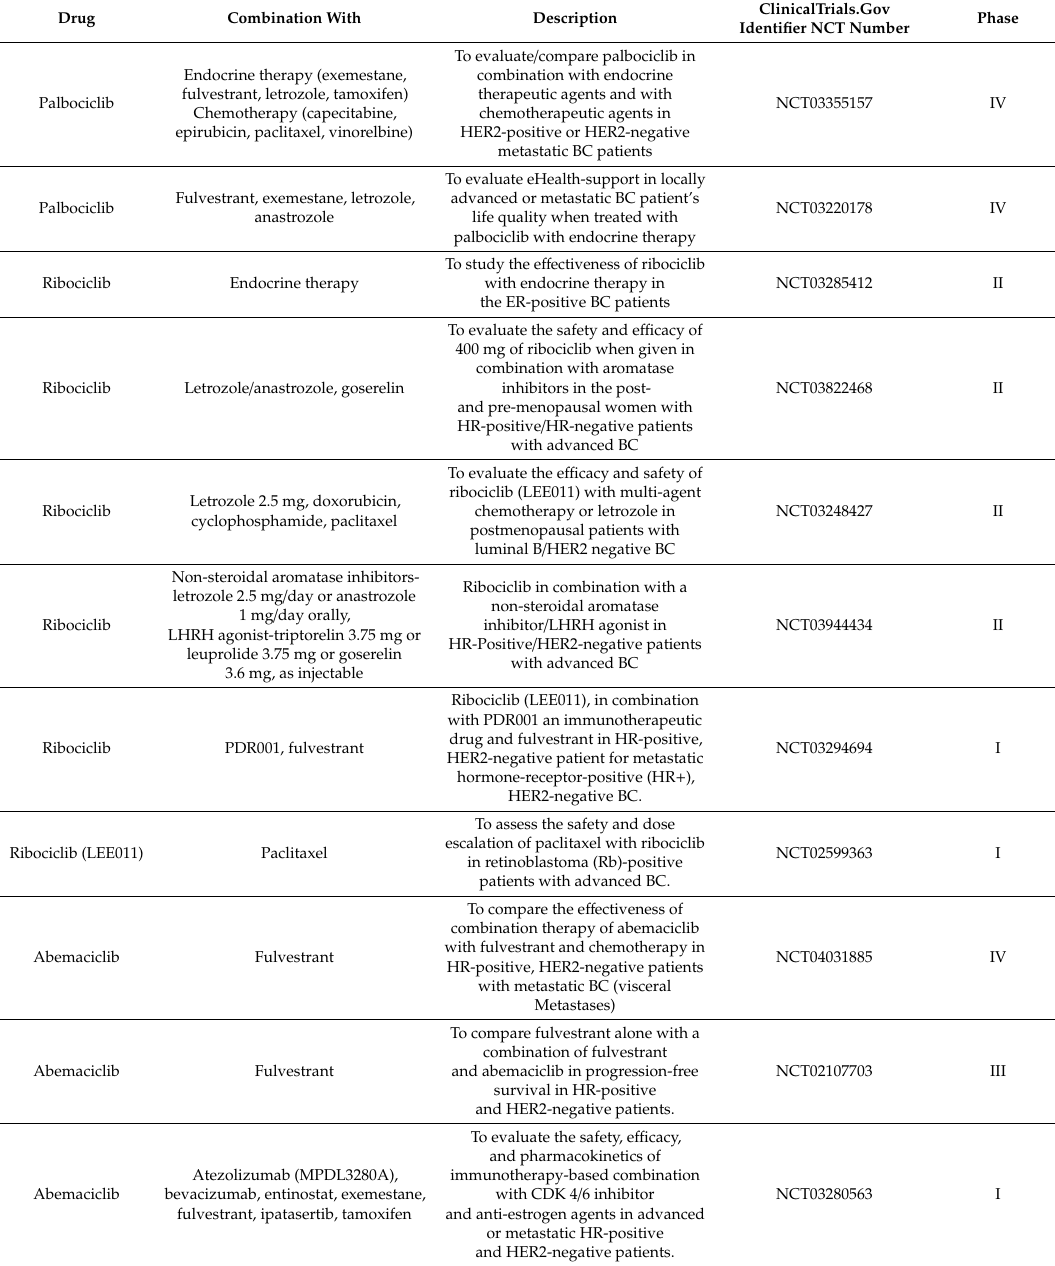
Table 2. CDK4 / 6 inhibitors with other chemotherapeutic agents in clinical trials as combination therapy. Drug Combination With Description ClinicalTrials.Gov Identifier NCT Number